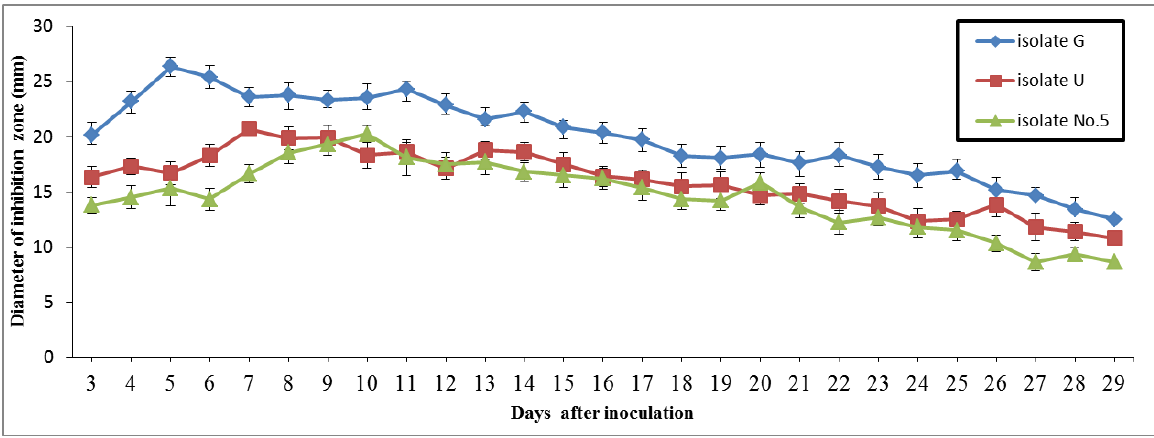
Figure 3. Diameter of inhibition zone (mm) of antagonist’s culture filtrates against Rhizoctonia solani versus post seeding time using well diffusion method.